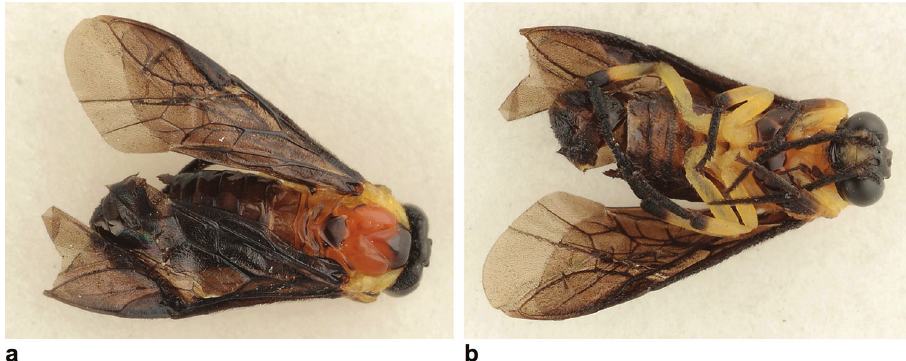
Figure 4. Ptenos delta , female (P4119.C), body length 6.5 mm. a Dorsal view b ventral view. Scobina inculta (Konow, 1906a) Fig. 5 Material. Estación científica Yasuní, 00°36'S, 076°30'W, 240m, 14.11.2016, by sweeping, P4215.E (1 ♂ ), leg. J.-L.